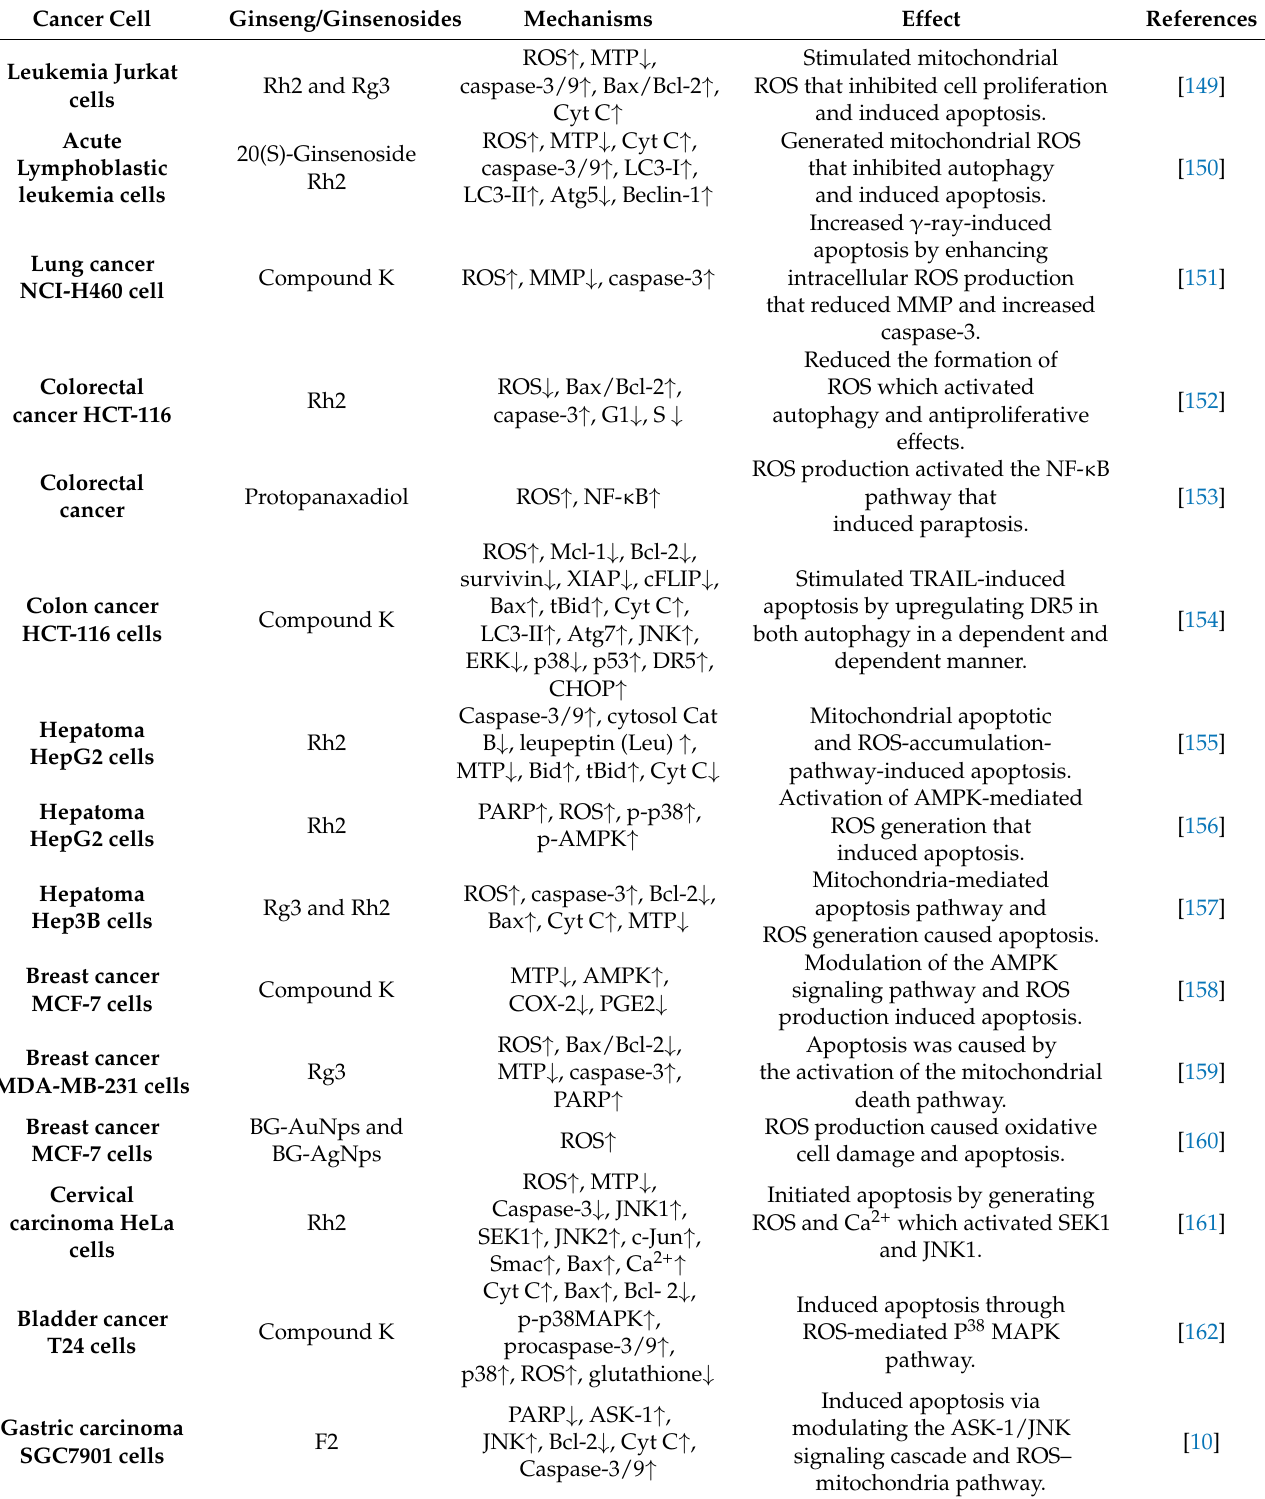
Table 2. ROS-associated effects of ginseng and ginsenosides on cancer